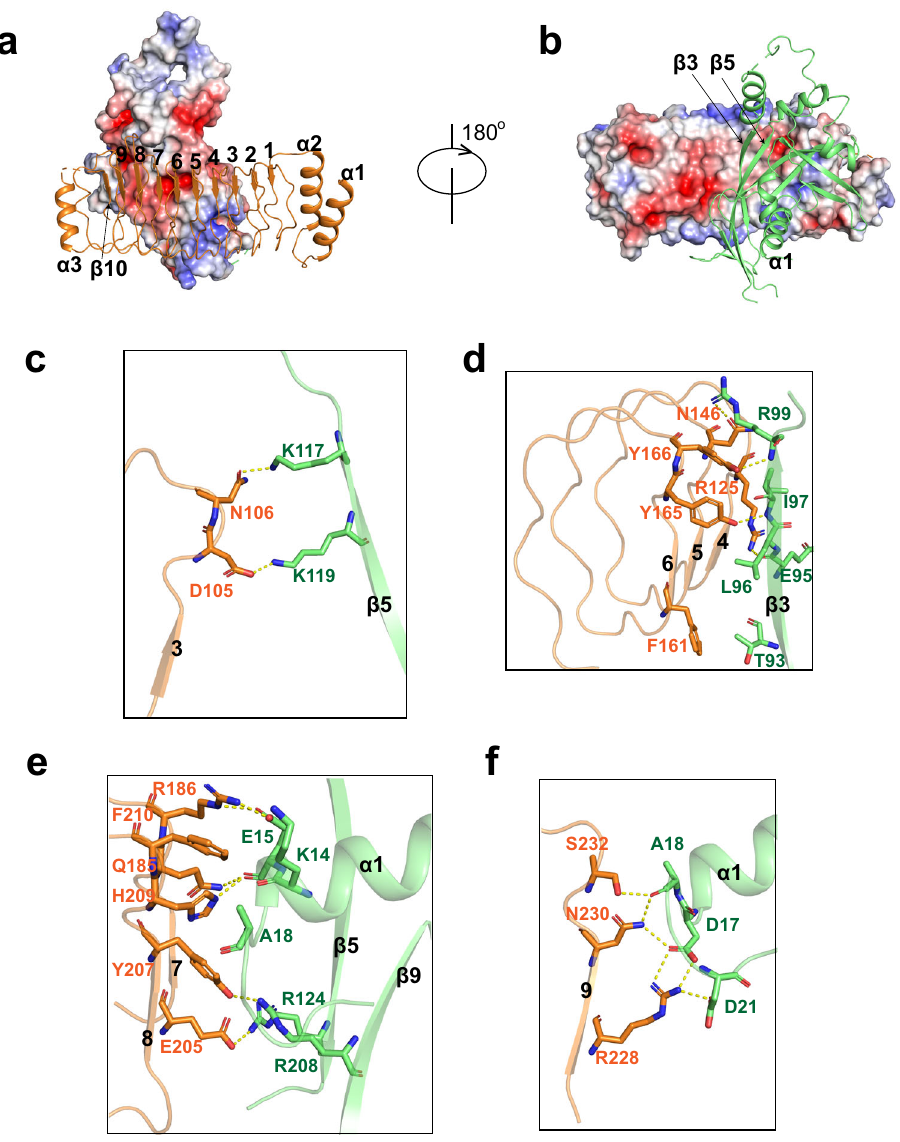
Fig. 4 | Recognition mechanism of GSDMB by IpaH7.8. a Electrostatic surface representations of NTD-GSDMB; LRR is shown in cartoon representation. The LRR units are indicated by numbers. b Electrostatic surface representations of